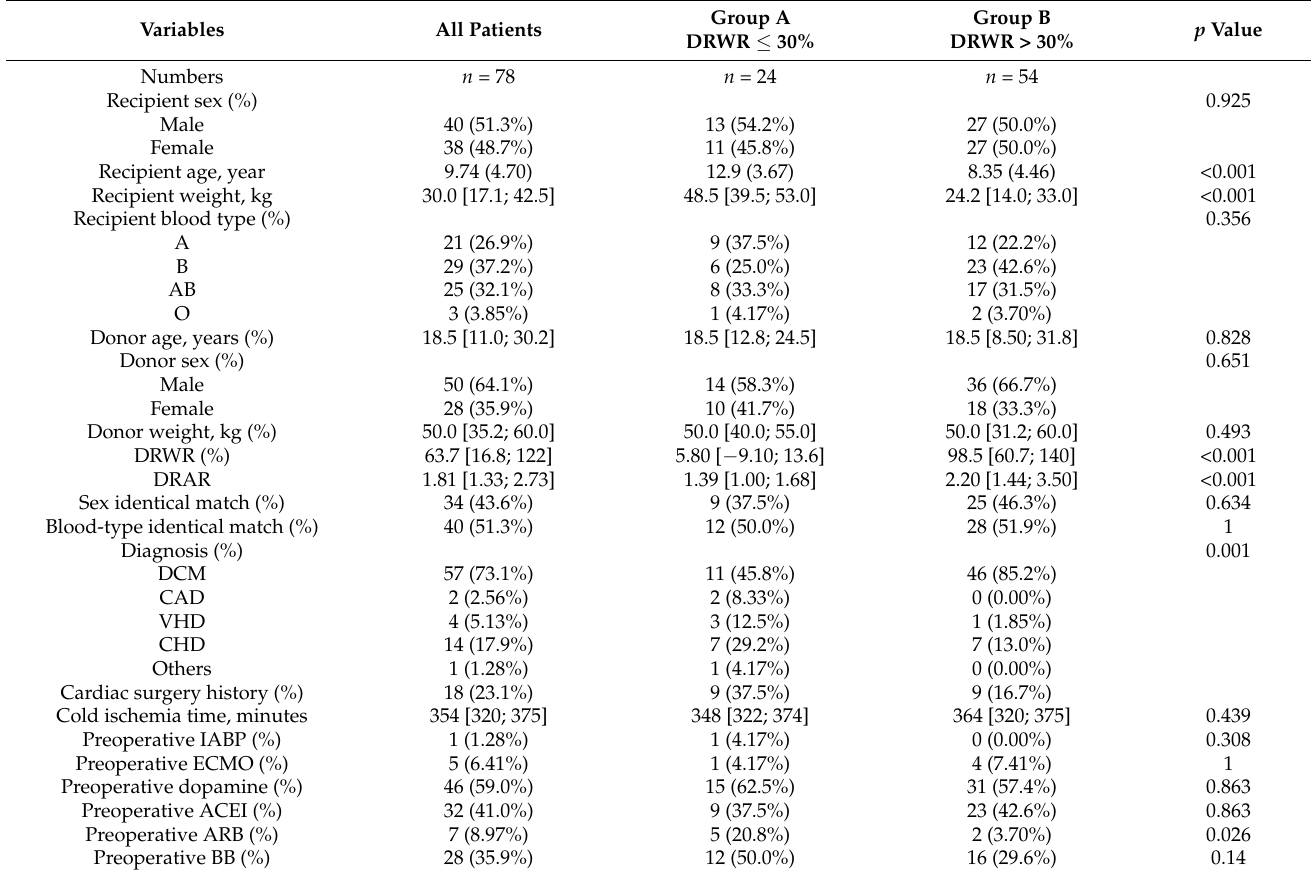
Table 1. Baseline characteristics.